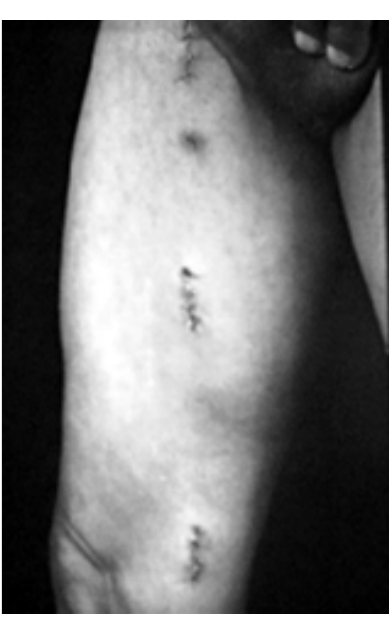
Fig. 2 - Aspecto final com sete dias de